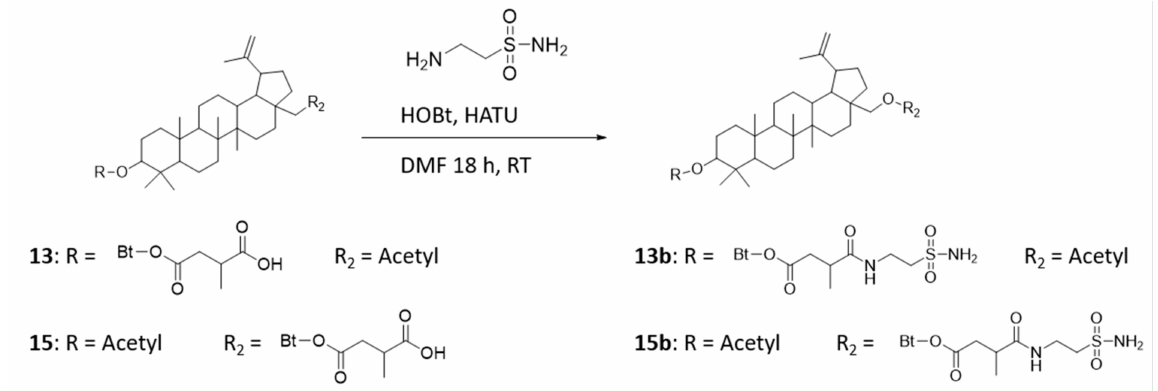
Figure 12. Preparation of (1R)-3a-(acetoxymethyl)-5a,5b,8,8,11a-pentamethyl-1-(prop-1-en-2-yl)icosahydro-1H- cyclopenta[a]chrysen-9-yl 3-methyl-4-oxo-4-(2-sulfamoylethylamino)butanoate (compound 13b ) and (((1R)-9-acetoxy- 5a,5b,8,8,11a-pentamethyl-1-(prop-1-en-2-yl)icosahydro-1H-cyclopenta[a]chrysen-3a-yl)methyl 3-methyl-4-oxo-4-(2- sulfamoylethylamino)butanoate) (compound 15b